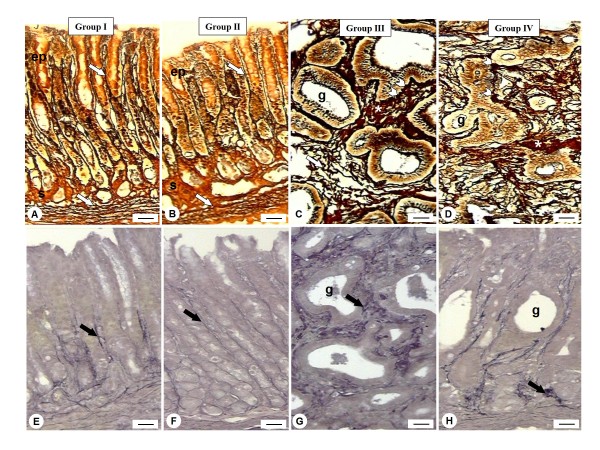
Histochemical analysis of reticular (A-D) and elastic fibers (E-H) in the rat stomachs. A and B) Groups I and II presented reticular fibers rectilinear and aligned (arrows) surrounding the epithelium (ep) and the stroma (s). C and D) Reticular fibers (arrow) winding and apparently densest at the base (arrowheads) of glands (g). Collagen fibers accumulation between the glands (*) were observed. E and F) The glands are accompanied by a delicate web of elastic fibers (arrow) and more intensely marked in E. G and H) An increase in the thickness of these fibers, disruption and fragmentation of fibrillar variables grouped masses of elastin (arrows) can be observed around the glands (g) compared to their respective control groups (I and II). Gomori's silver (A-D); Weigert's Resorcin-Fuchsin (E-H). Bars: 10 μm.